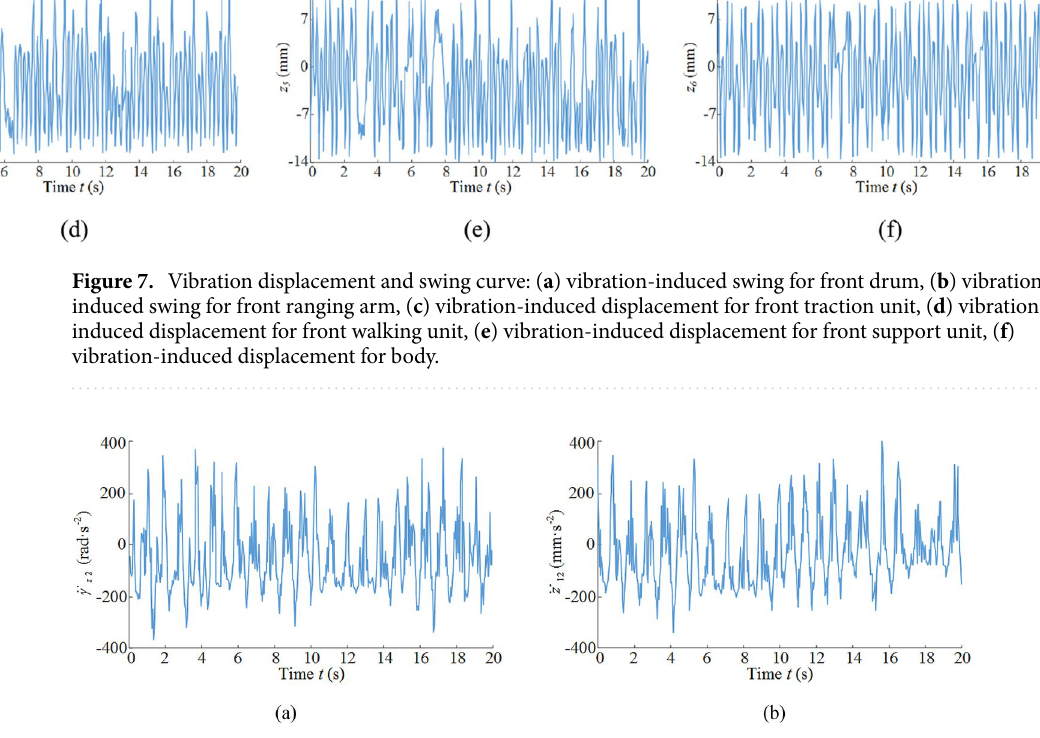
Figure 8. Vibration acceleration curve: ( a ) vibration-induced acceleration for front ranging arm, ( b ) vibration- induced acceleration for front walking